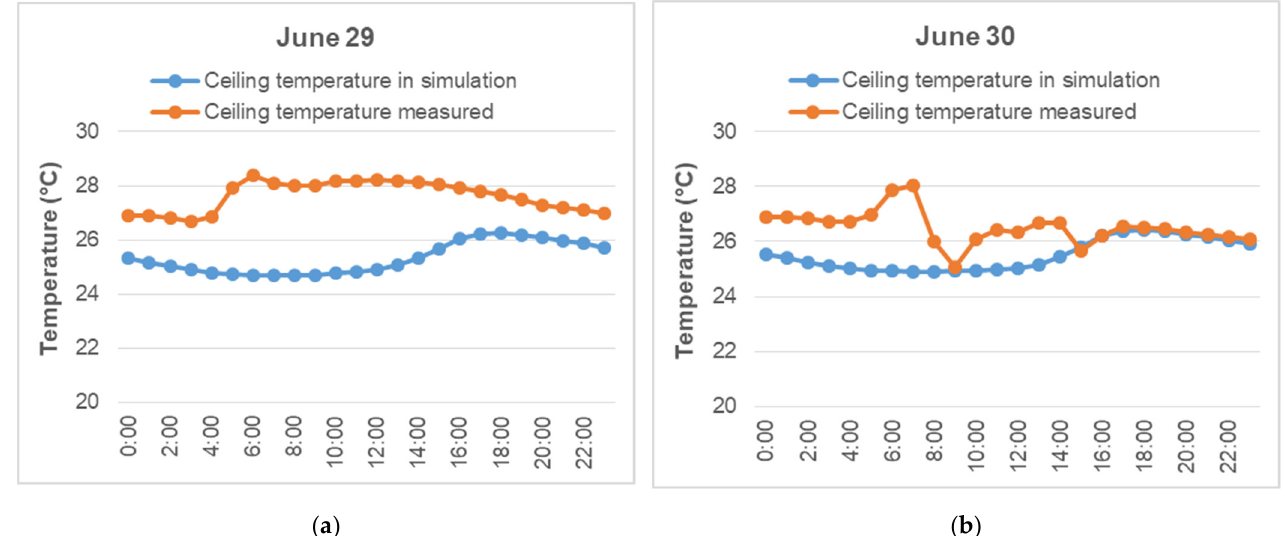
Figure 11. Comparison of all-day surface temperature profiles on a window structure from measured values with simulation: ( a ) for 29 June, ( b ) for 30 June.